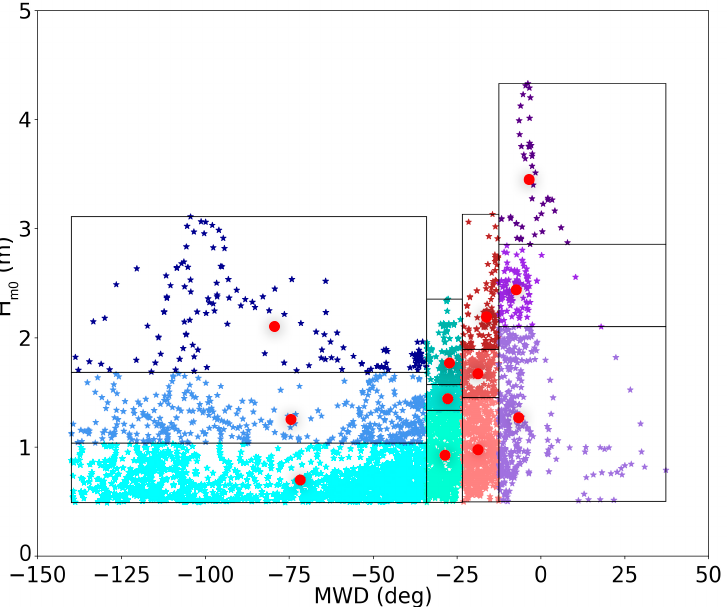
Figure 5. The 12 equal Energy Flux bins (rectangles) and the 12 representative wave conditions (red circles) derived from the Energy Flux Method (1 January 2021–31 December 2021).